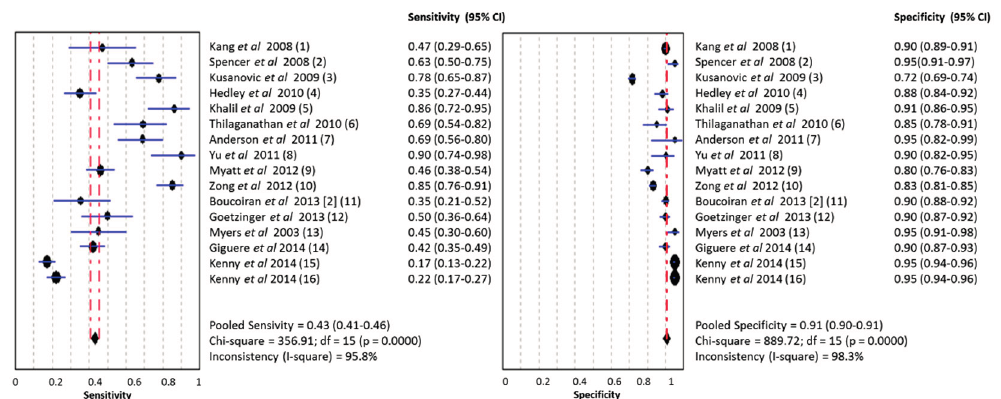
Figure 6. Meta-analysis of combination of laboratory and clinical makers in PE (both EOPE and LOPE). Legend: ( 1 ) PAPP-A, AFP, uE3, hCG (total or free β ), inhibin-A; ( 2 ) mean PI + activin-A; ( 3 ) PlGF/sEng-ratio; ( 4 ) PAPP-A and free leptin index; ( 5 ) PP-13, UA-PI, AIx-75 (measure of arterial stiffness); ( 6 ) cystatin-C, CRP, uterine artery resistance index; ( 7 ) HbF ratio and A1M; ( 8 ) activin-A, inhibin-A, PlGF and UA-PI; ( 9 ) African American race, systolic blood pressure, BMI, education level, ADAM12, PAPP-A, PlGF; ( 10 ) BMI, education mother and HtrA1; ( 11 ) maternal characteristics, PlGF; ( 12 ) maternal characteristics, ADAM12; ( 13 ) maternal characteristics, PlGF; ( 14 ) sFLT-1, PlGF, PAPP-A, inhibin A, BMI, MAP; ( 15 ) PlGF, MAP, BMI, high fruit intake, uterine artery Doppler resistive index (UA-RI) * validation cohort; ( 16 ) PlGF, MAP, BMI, high fruit intake, UA-RI * training cohort.